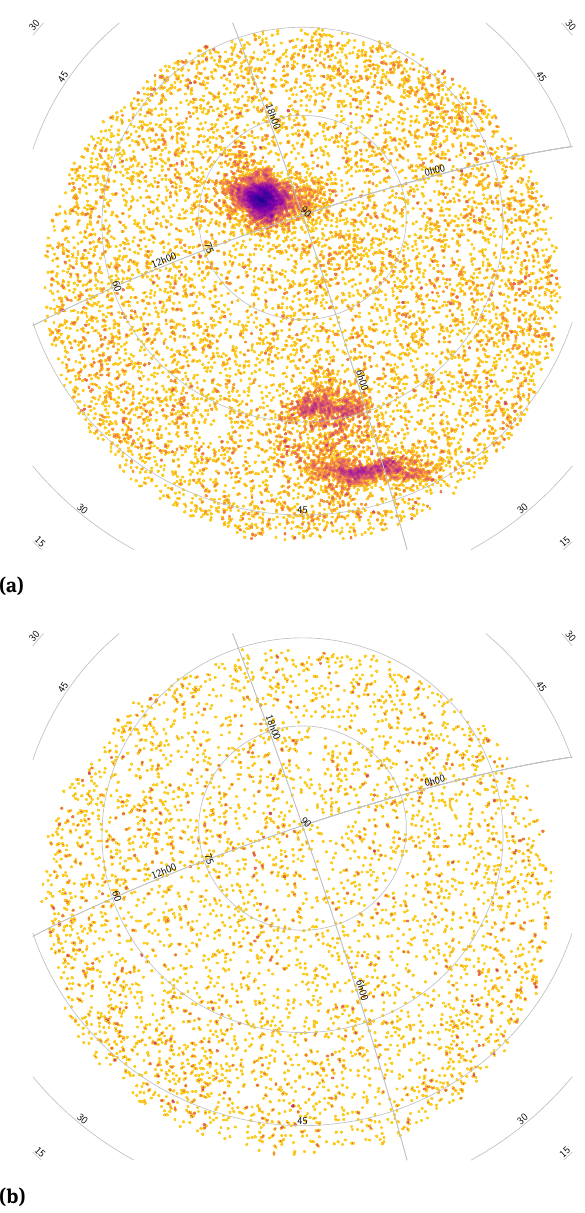
Figure 2. Scatterplots showing the sky positions of pairs from real (left) and background model (right) data. More densely populated areas are closer to purple color. Generated pairs are notably